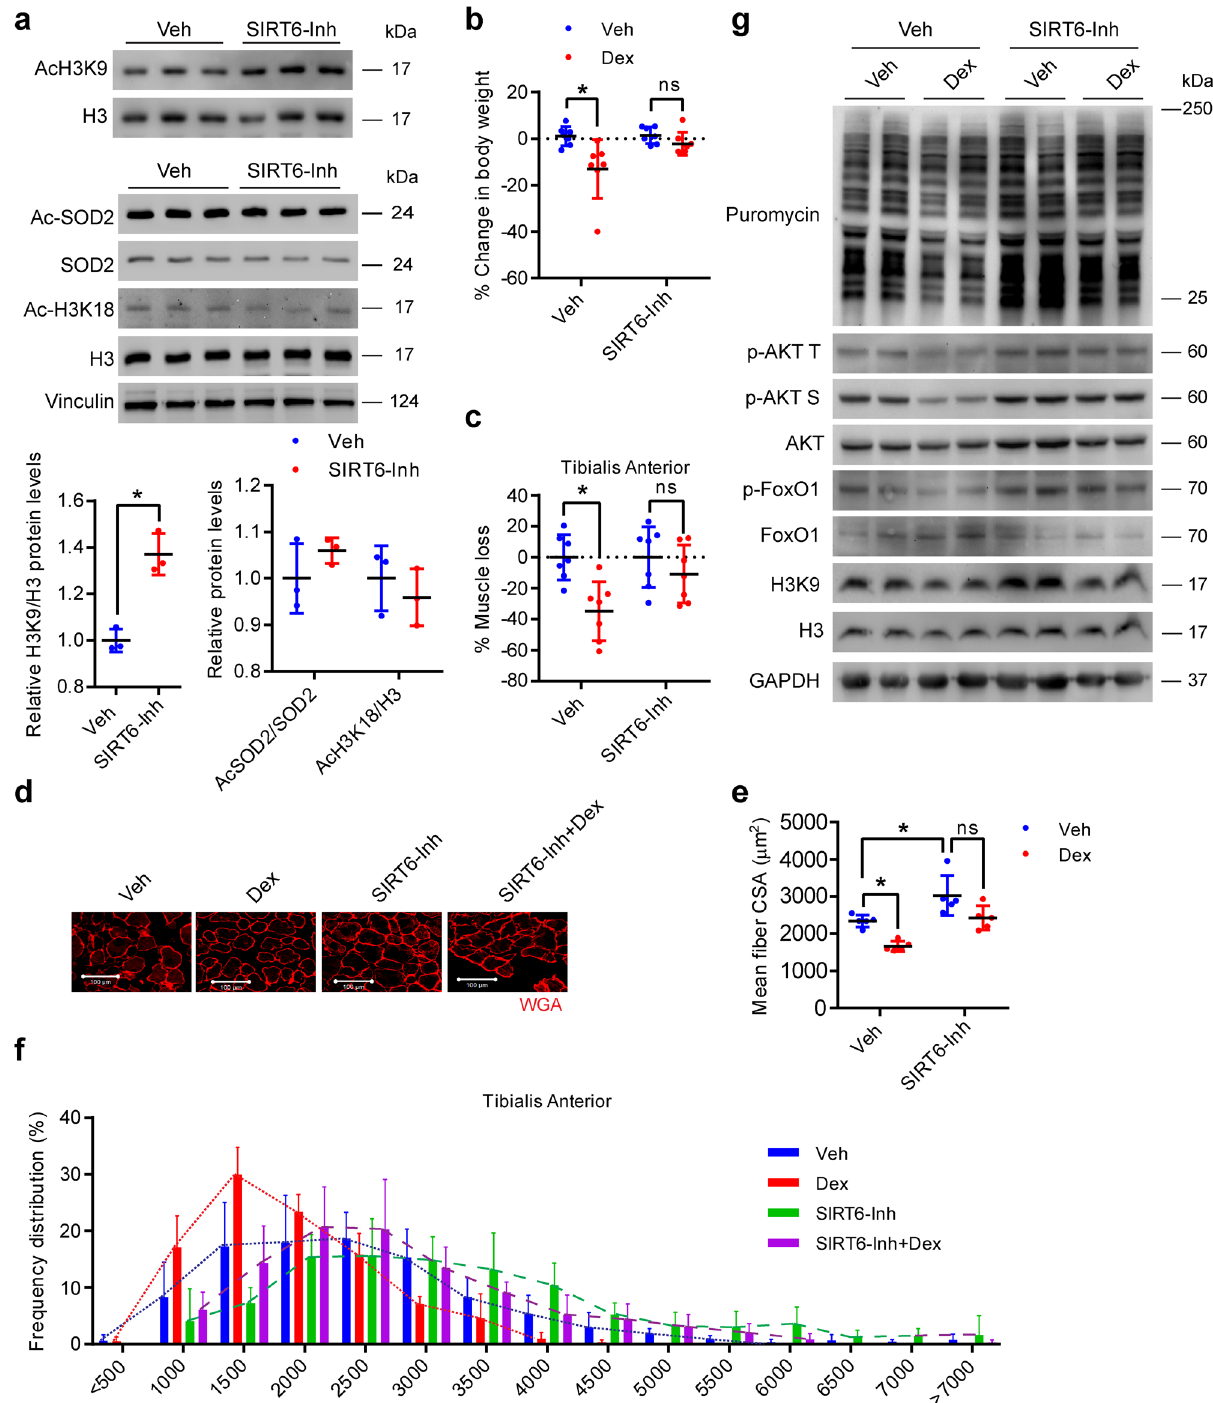
Fig. 10 | SIRT6 inhibition protects mice against dexamethasone-induced muscle atrophy. a Western blotting (top) and relative quanti fi cation (bottom) indicating the increase in global acetylation of histone 3 at lysine 9 in the gastro- cnemius muscle of SIRT6 inhibitor (SIRT6-Inh) administered mice. Western blot (middle) and relative quanti fi cation (bottom) of protein levels of acetylated SOD2 and global acetylation of histone 3 at lysine 18 normalized to SOD2 and histone 3 respectively in SIRT6-Inh treated mice soleus muscle. n =3. b Change in body weight in SIRT6-Inh treated mice after Dex injection. n =7. c Loss in TA muscle massfromSIRT6-Inhtreated miceafterDexinjection. n =7.% ofmusclelossinthe Dex or SIRT6-Inh-Dex group is shown relative to Veh injected mice for the respective group. d Representative images showing WGA (red) stained SIRT6-Inh